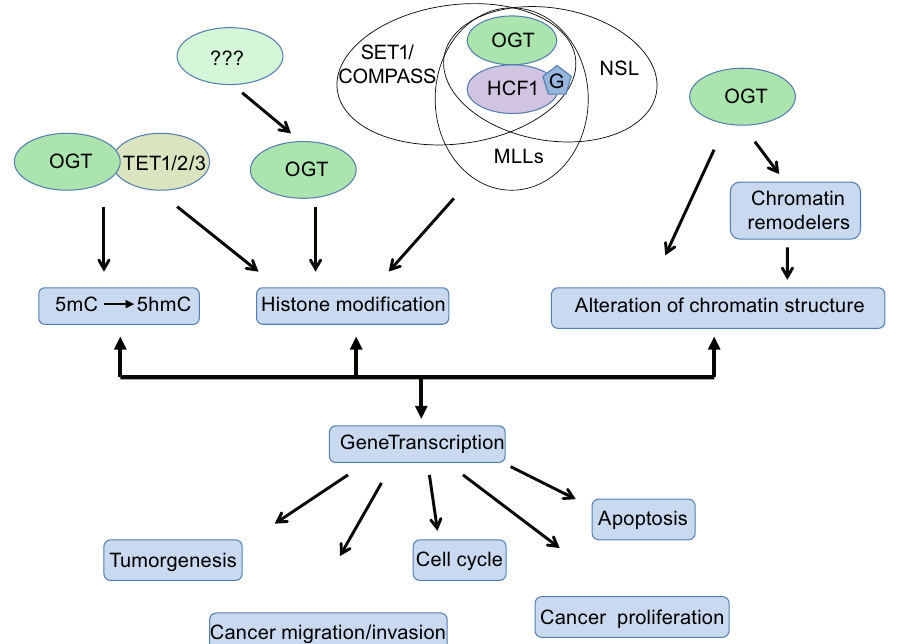
Figure 4. Schematic diagram of coordination between OGT-mediated O -GlcNAcylation and chromatin remodelers in intracellular fundamental